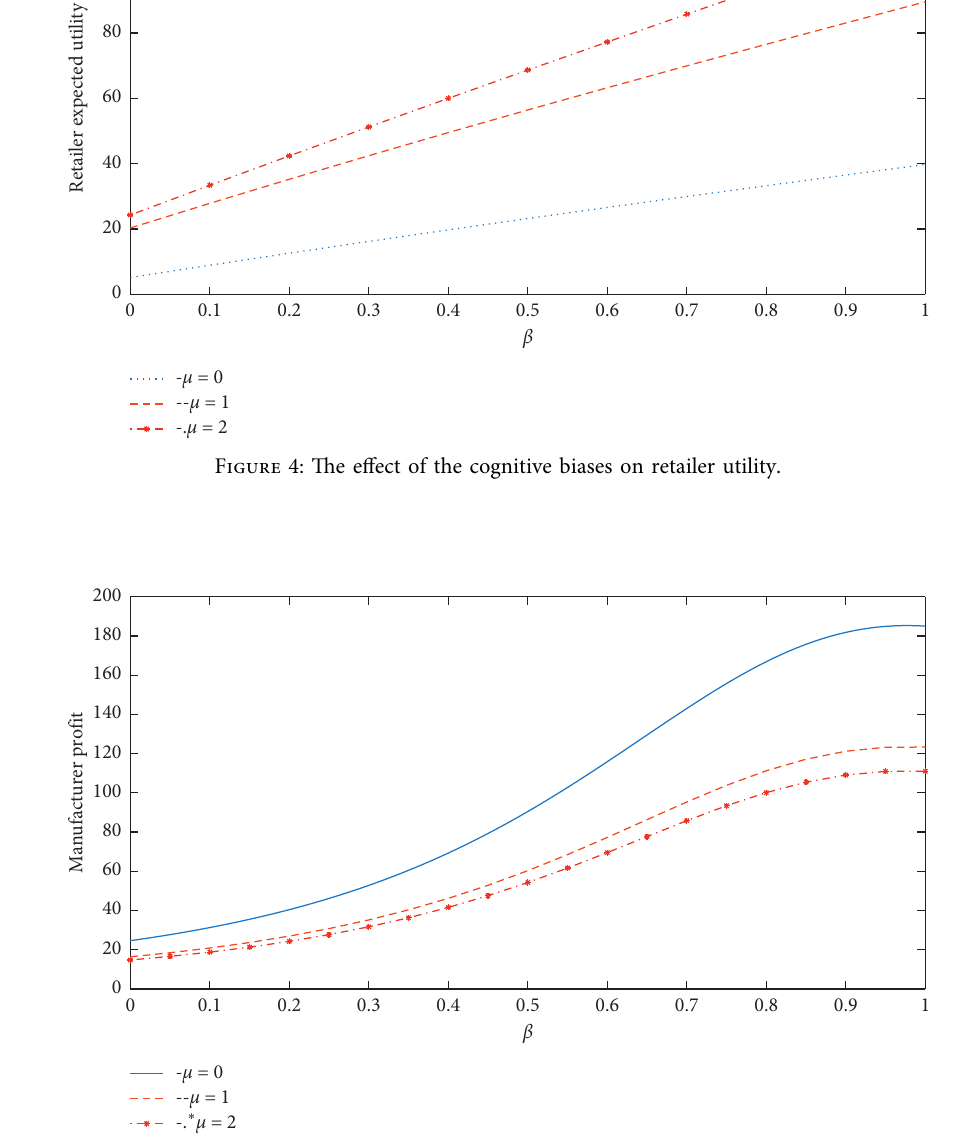
Figure 5: The effect of the cognitive biases on manufacturer